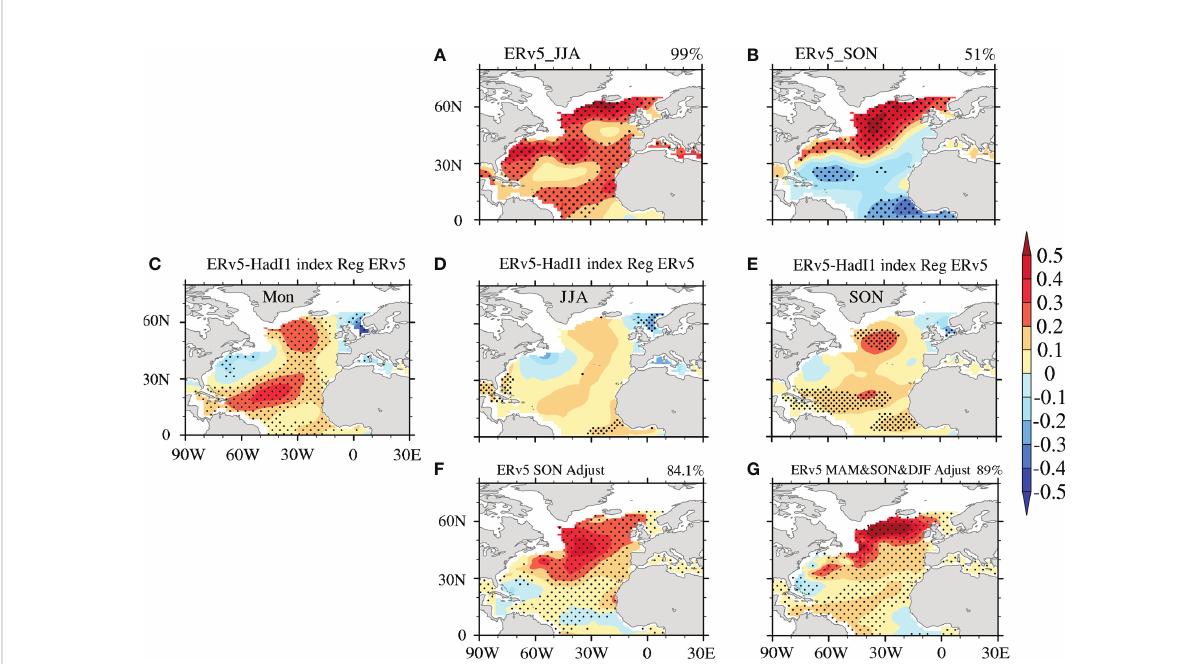
FIGURE 6 The AMO pattern extracted from the seasonal mean ERv5 SST in (A) JJA and (B) SON during 1900 – 2019 by LFCA. (C – E) Regression patterns of the ERv5 SSTA onto the difference (ERv5 minus HadI1) in the AMO index (de fi ned by the averaged SSTA in the North Atlantic) with a 6-year running mean for the (C) monthly, (D) JJA, and (E) SON data during 1934 – 1950. (F, G) The AMO pattern extracted from the adjusted (F) SON and (G) monthly ERv5 data during 1900 – 2019 by LFCA. The adjusted SON ERv5 data in (F) are obtained by fi rst removing the SON seasonal SST difference (ERv5 minus HadI1) from the monthly ERv5 data during 1934 – 1950, and then computing the SON seasonal mean SST during 1900 – 2019. The adjusted monthly ERv5 data in (G) are obtained by removing the MAM, SON and DJF seasonal SST differences from the monthly ERv5 data during 1934 – 1950. The AMO CI value is given in the top right. The dots indicate statistical signi fi cance at the 95% con fi dence